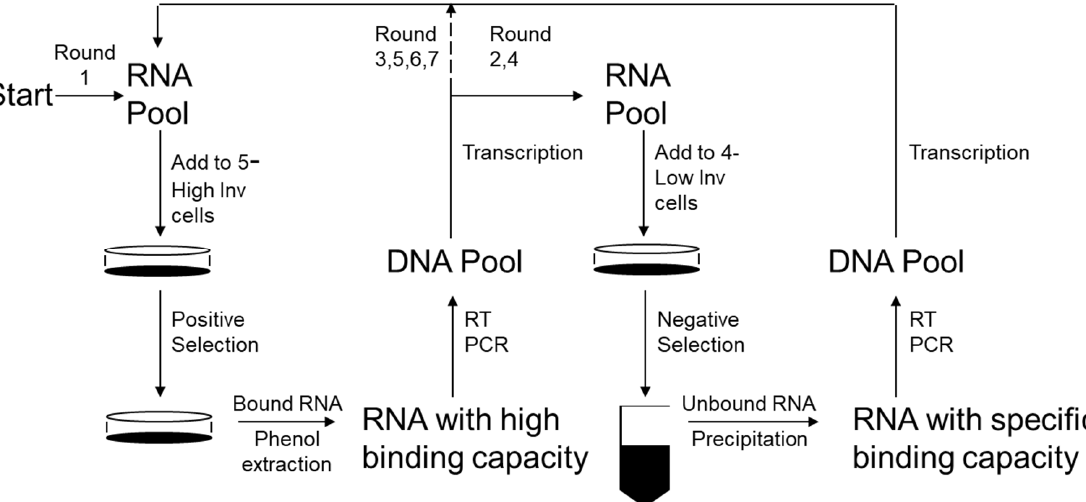
Figure 2. Schematic of SELEX procedure. RNA with high binding capacity was obtained from an RNA pool of 10 14 RNA molecules 103 bp long containing a 40 bp random sequence flanked by two primer binding sites by adding to highly invasive cells and extracting the bound RNA, which was used to prepare an RNA pool with specific properties. The RNA with general binding capabilities was then removed by mixing the pool with noninvasive cells and using the unbound RNA to prepare a fresh RNA pool.